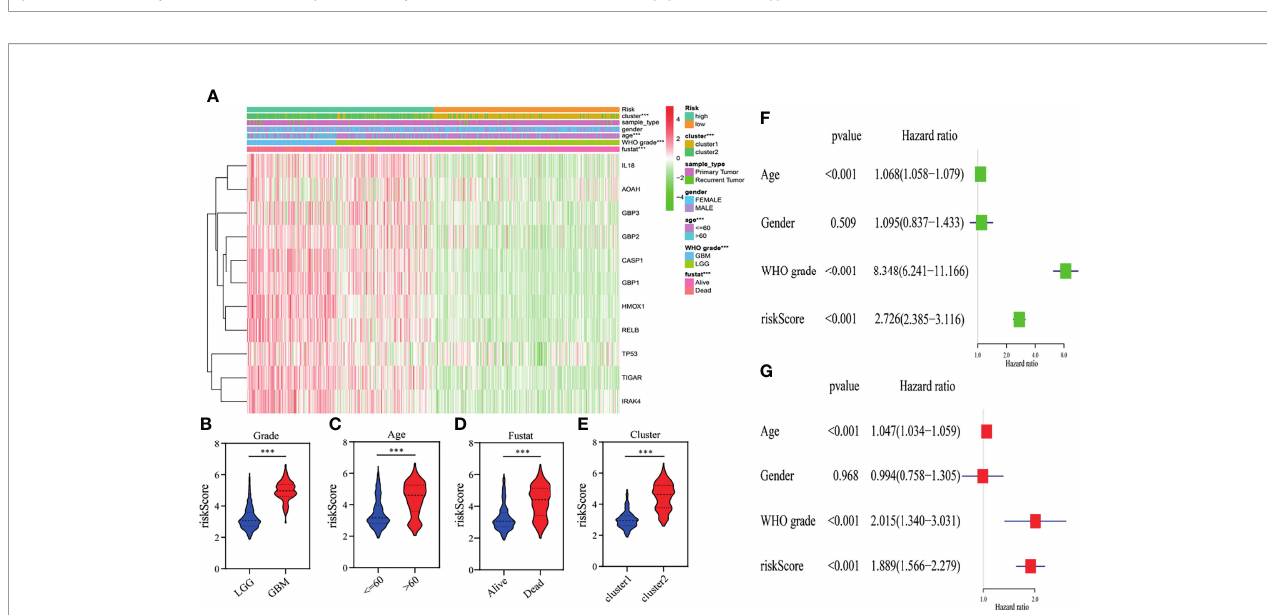
FIGURE 4 | Relationship between the clinicopathological characteristics, cluster 1/2 groups and risk score in the TCGA dataset. (A) The heatmap displays the differential distribution of clinicopathological features and eleven pyroptosis-related gene expression levels in gliomas with low and high risk. (B – E) The WHO grade (B) , age (C) , fustat (D) , and cluster 1/2 subgroups (E) stratify the TCGA dataset, and the distribution of risk scores is shown. *** p < 0.001. (F, G) Univariate (F) and multivariate (G) analyses for the TCGA cohort including age, gender, WHO grade and risk score.